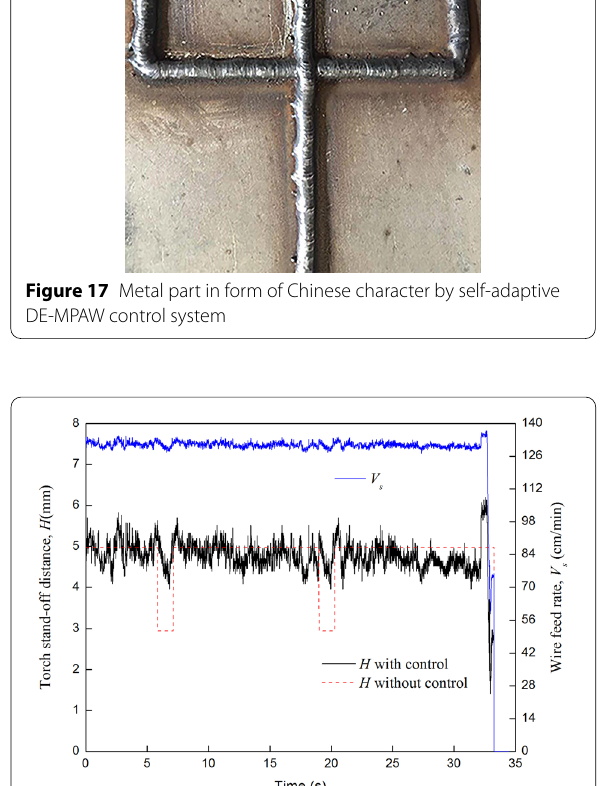
Figure 16 Schematic of depositing the metal material in form of Chinese characters using self-adaptive DE-MPAW control system